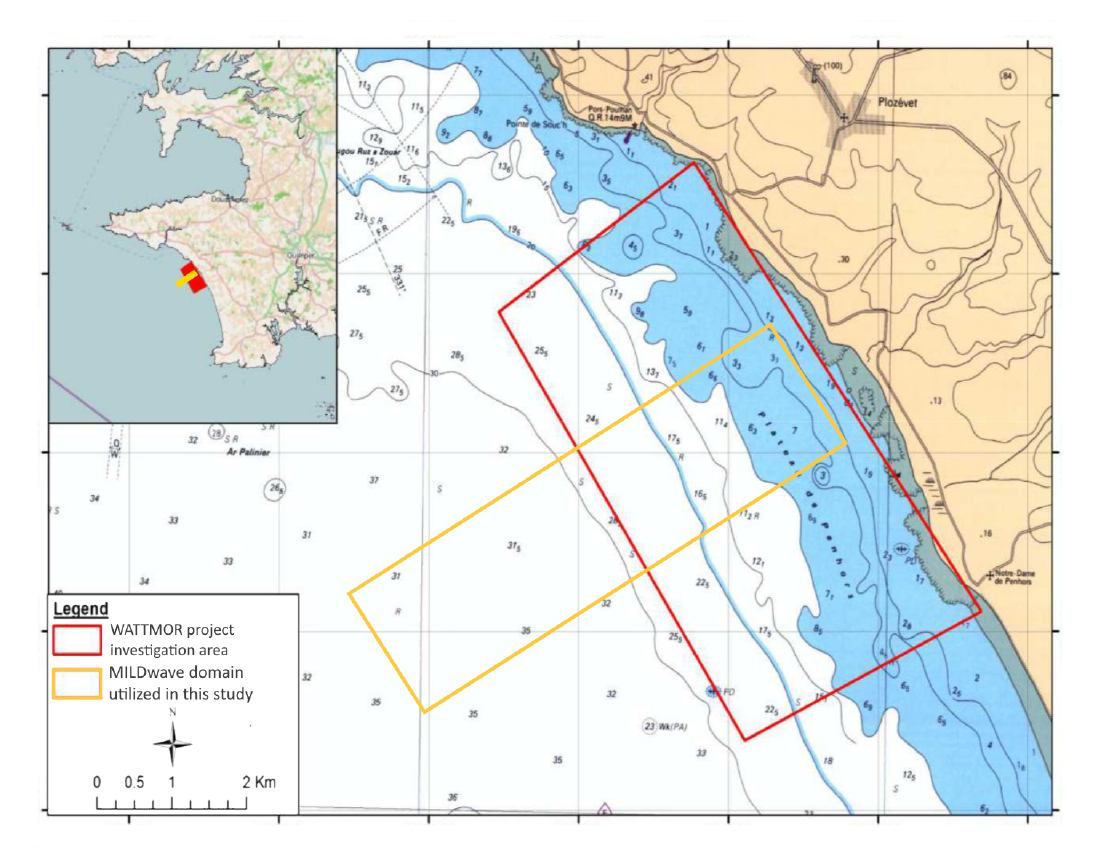
Figure 2. Detailed map showing the project area (red box) and the W2W model domain investigated in this study (yellow box). Point water depths are shown in meters